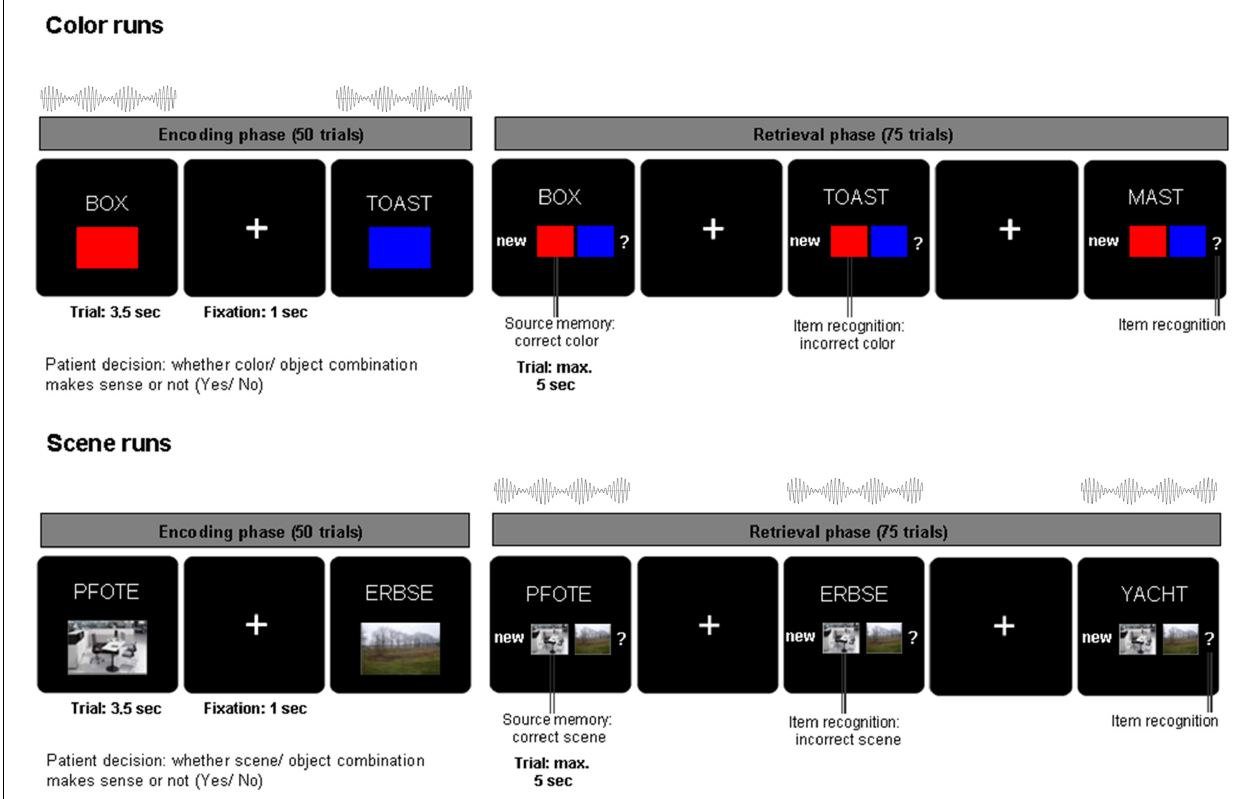
FIGURE 1 | Associative learning paradigm and beat stimulation. During encoding, nouns were presented in combination with one of two colors or one of two scenes for 3.5 s and patients indicated whether the combination was plausible or not. During retrieval, the previously presented nouns along with previously unstudied nouns were shown for a maximum of 5 s. Patients indicated their memory of the noun color/scene association with one of four possible responses: (i) new noun, (ii) old noun associated source one, (iii) old noun associated source two, (iv) old noun but unable to remember association. Auditory beat stimulation was presented either during the encoding (color runs, top) or during retrieval phase (scene runs,